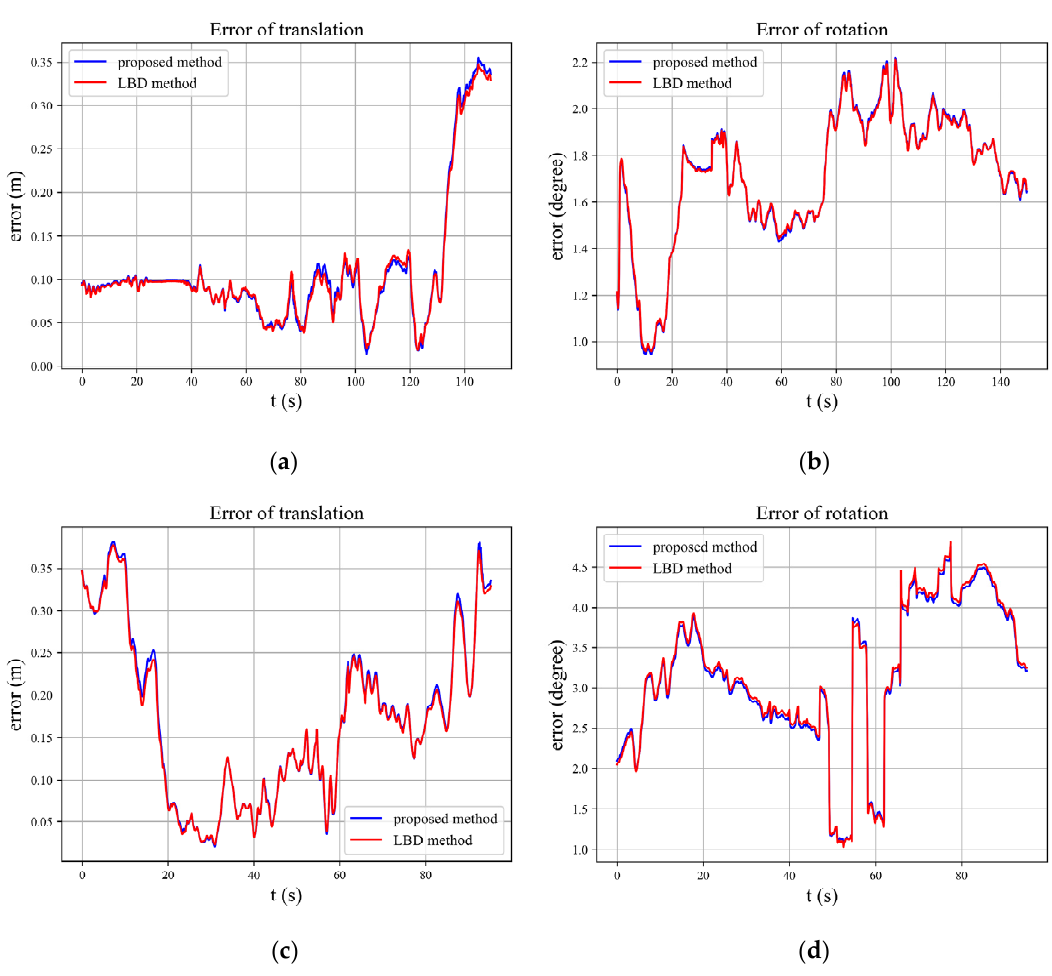
Figure 7. Comparison of improved matching method and LBD descriptor matching method: ( a , c ) compare translation errors on the MH_02_easy and V1_03_difficult datasets; ( b , d ) compare rotation errors on the MH_02_easy and V1_03_difficult datasets.